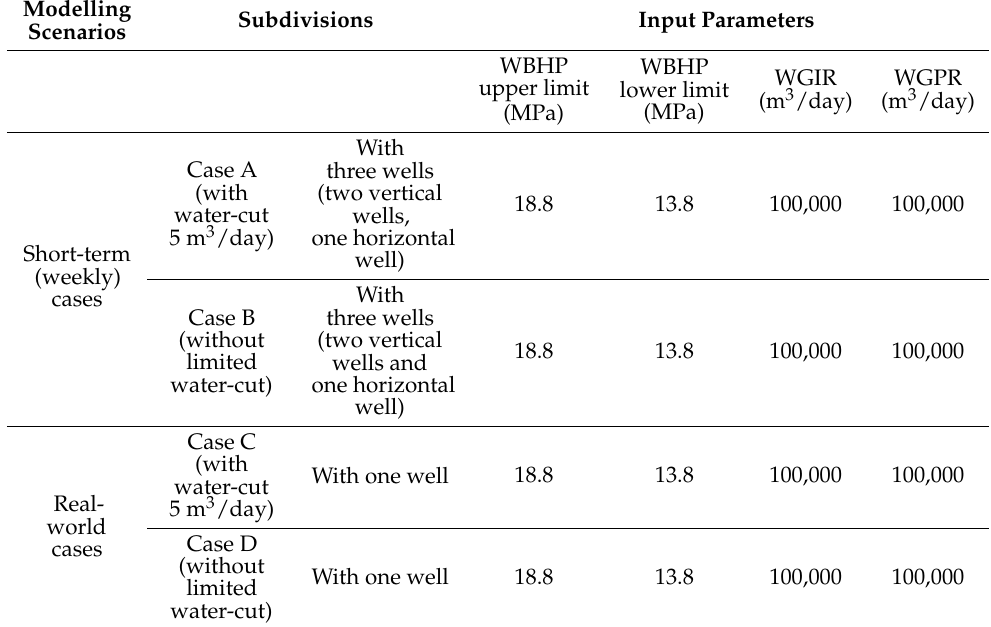
Table 1. All modelling scenarios with input parameters. WBHP is well bottom hole pressure, WGIR is well gas injection rate, and WGPR is well gas production